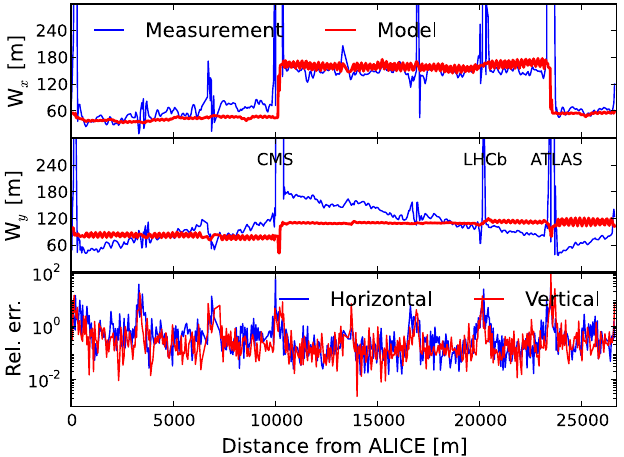
FIG. 11. Beam 1 horizontal (upper) and vertical (middle) Montague functions as defined in Eq. (3). The model function is shown in red, and the measurement in blue. The relative error of the measurements is shown in the lower plot. The figure shows the case for 0.6 m (cid:1) (cid:1) optics at 4 TeV beam energy, before corrections.